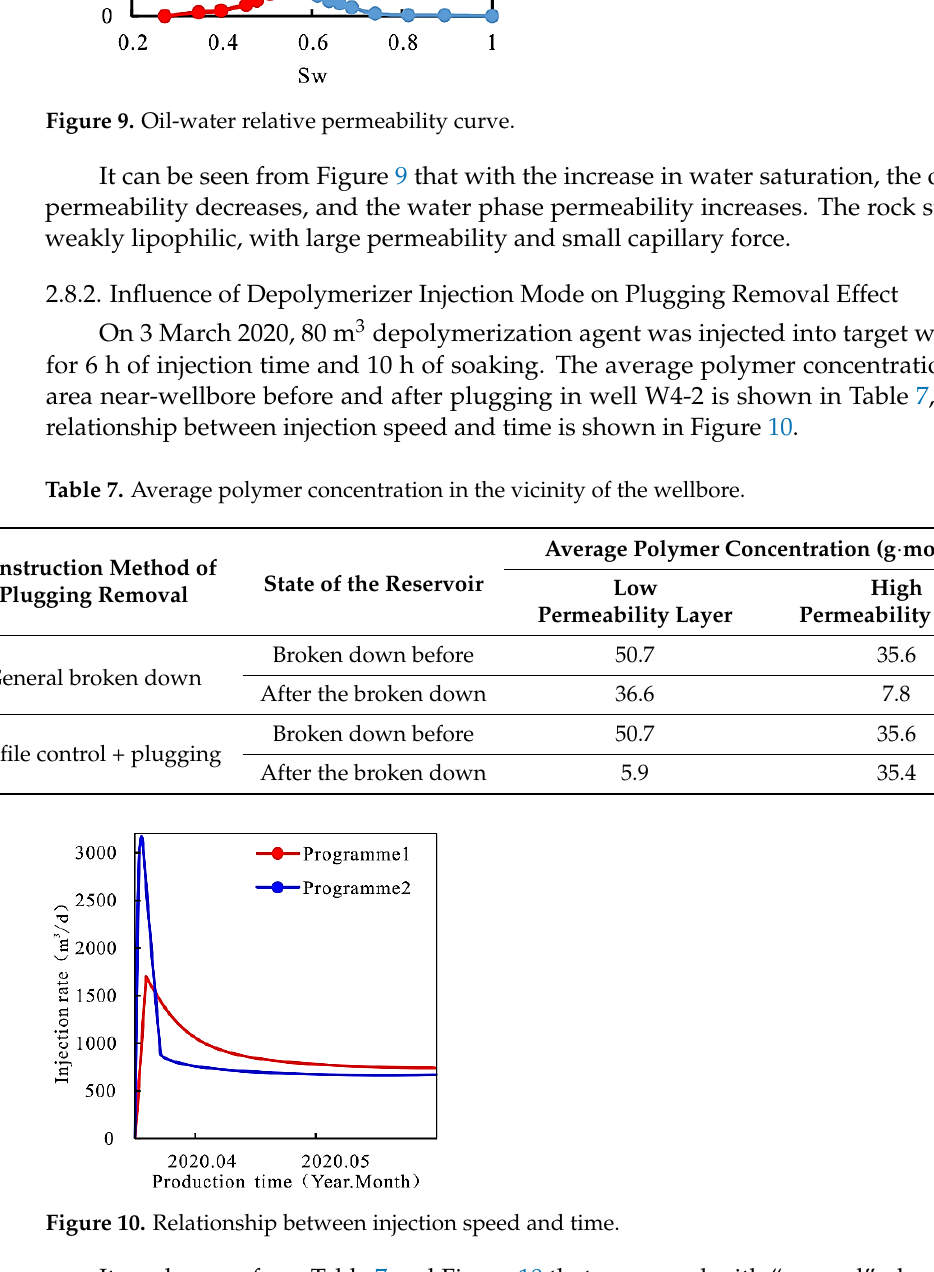
Figure 9. Oil-water relative permeability curve.